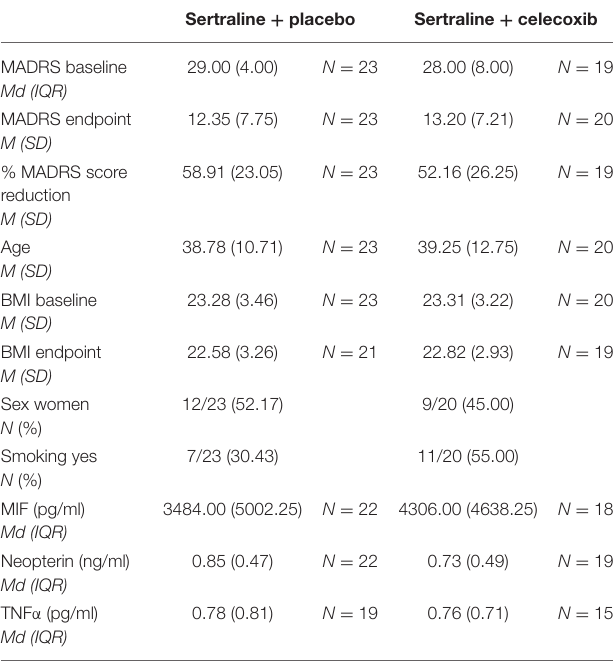
TABLE 1 | Descriptive characteristics of patients with MDD.